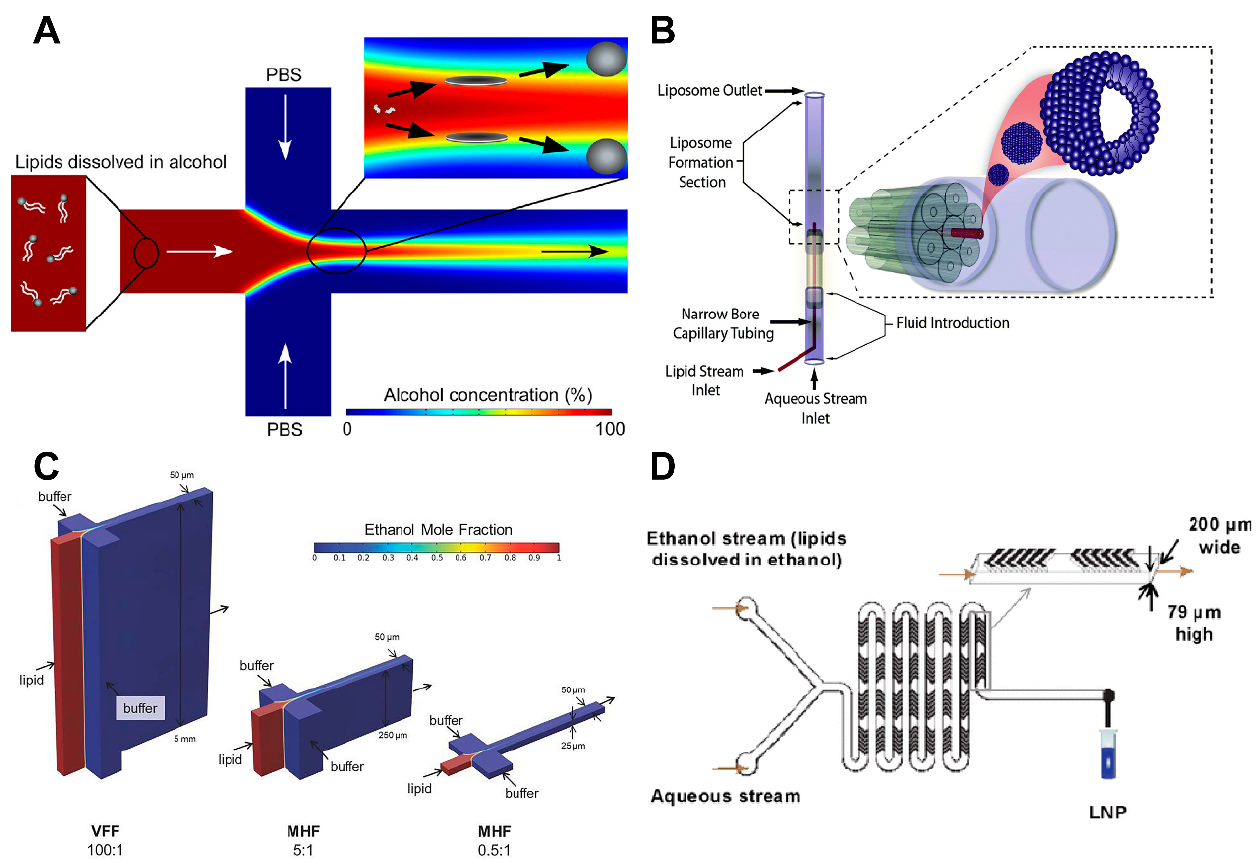
Figure 2. Schematic diagram of microfluidic methods. ( A ) Schematic of an example of the MHF method. Reproduced with permission from [40]. Copyright 2013, American Chemical Society. ( B ) An example of 3D-MHF. Reproduced with permission from [38]. Copyright 2014, Royal Society of Chemistry. ( C ) Vertical flow-focusing technique. Reproduced with permission from [30]. Copyright 2015, Wiley-VCH. ( D ) Schematic of lipid nanoparticles formulation process employing the stag- gered herringbone mixer (SHM) device. Reproduced with permission from [41]. Copyright 2012, American Chemical Society.